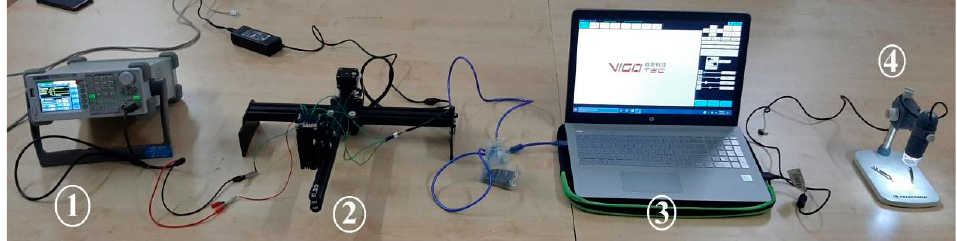
Figure 2. Machined buffalo leather samples under observation using a microscope: (1) waveform generator; (2) LBM setup; (3) software integration; (4) microscope.